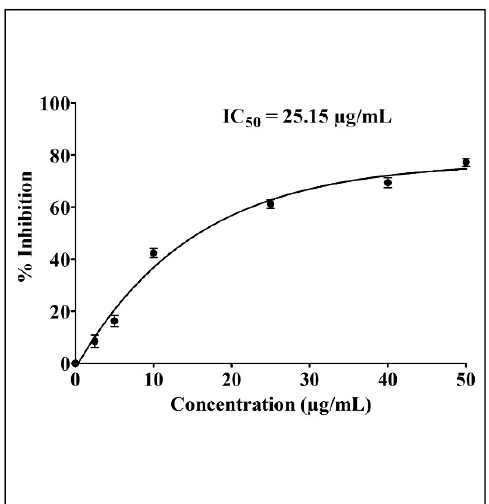
Figure 2. Cytotoxicity and IC 50 (estimated value 25.15 μ g/mL) of AgNPs on A549 cancer cells. Cell migration is the most significant metastatic event, which occurs during the pro ‐ gression of cancer in various epithelial cells. Therefore, wound healing and Transwell mi ‐ gration tests were carried out to determine the inhibitory potential of the synthesized AgNPs on A549 cancer cell migration. As seen in Figure 3A–F, 24 h post wounding, un ‐ treated A549 cancer cells slowly migrated to the clear area, while AgNP treatment inhib ‐ ited the A549 cancer cell migration. Furthermore, the outcome from the Transwell migra ‐ tion assay indicated that AgNP treatment might efficiently hinder the cell migration of A549 cancer cells in a concentration ‐ dependent mode, ranging from 18.84% to 91.53%, as presented in Figure 4A,B.